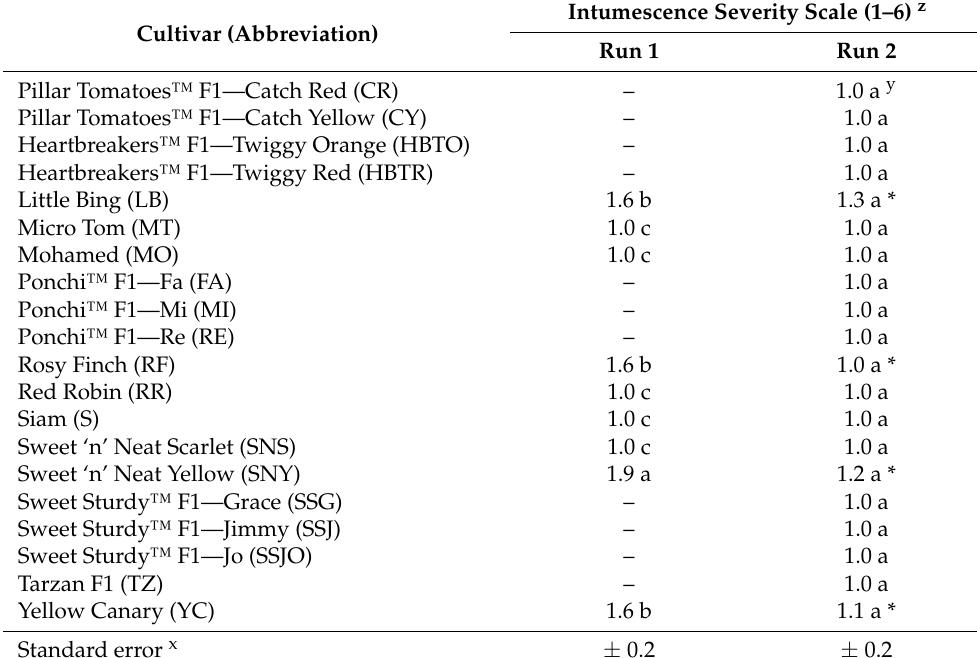
Table 3. Intumescence severity for compact tomato plants grown in an indoor environment during the two experimental